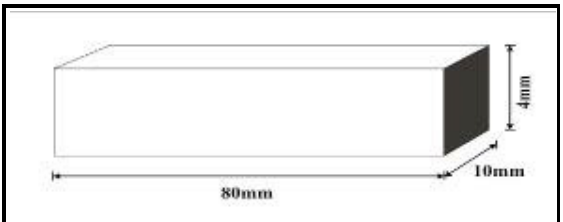
Fig. 8. Schematic Specimen for Standard Specimen of Impact